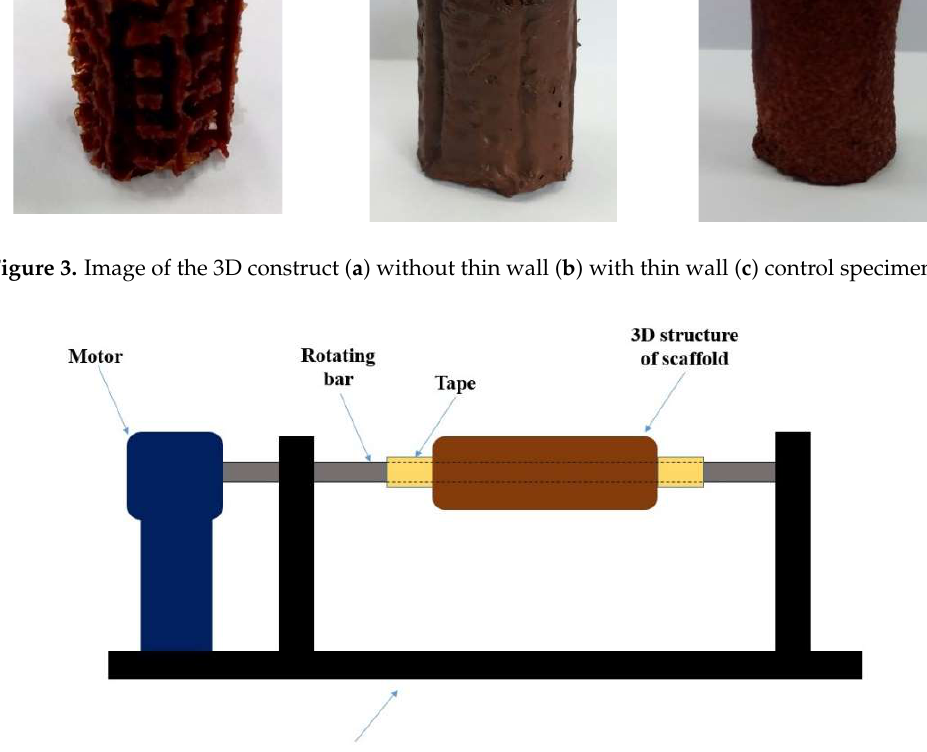
Figure 4. Schematic diagram of rotating electrospinning collector setup.